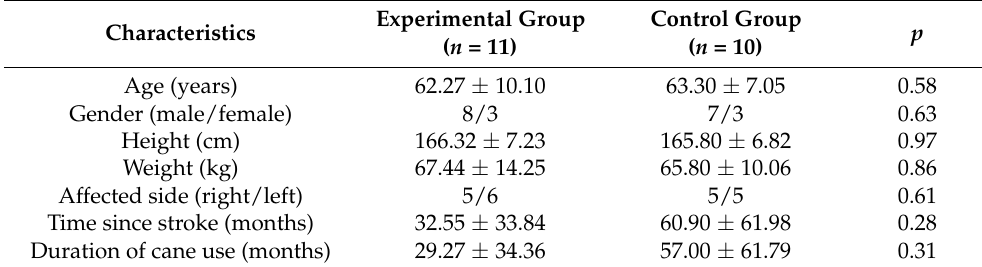
Table 1. Demographic and baseline characteristics of study participants.